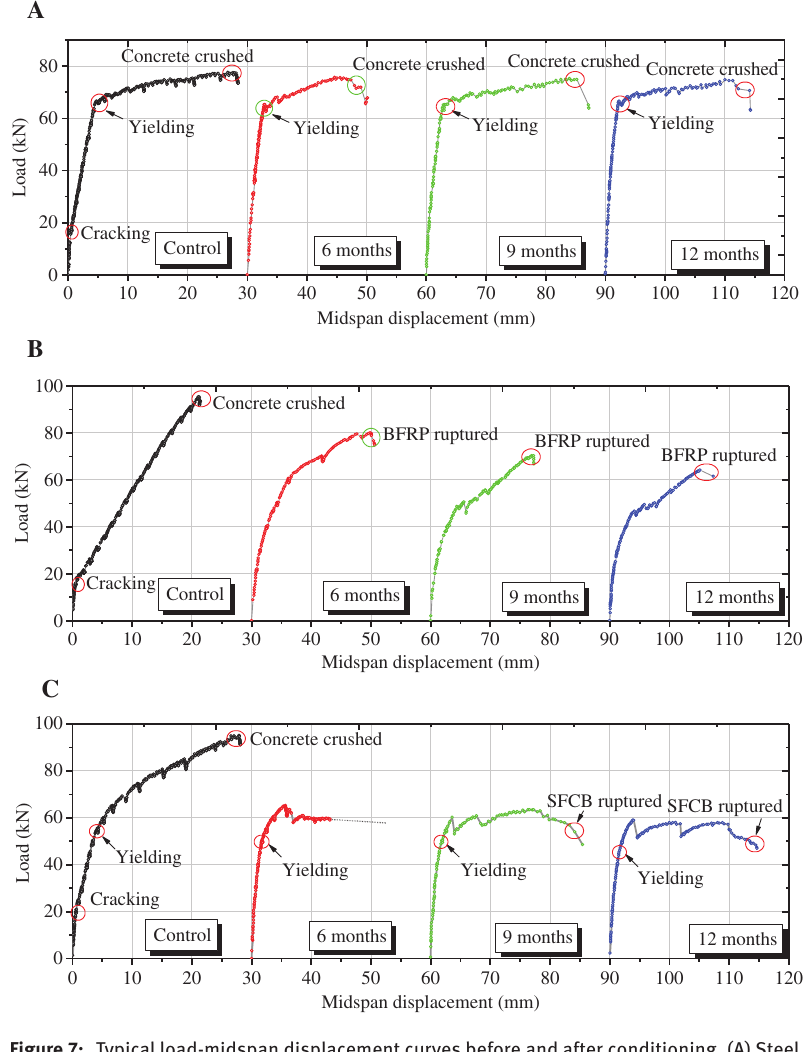
Figure 7: Typical load-midspan displacement curves before and after conditioning. (A) Steel bars RC beams, (B) BFRP bars RC beams and (C) SFCBs RC beams. Table 4: Summary of test results. Beam